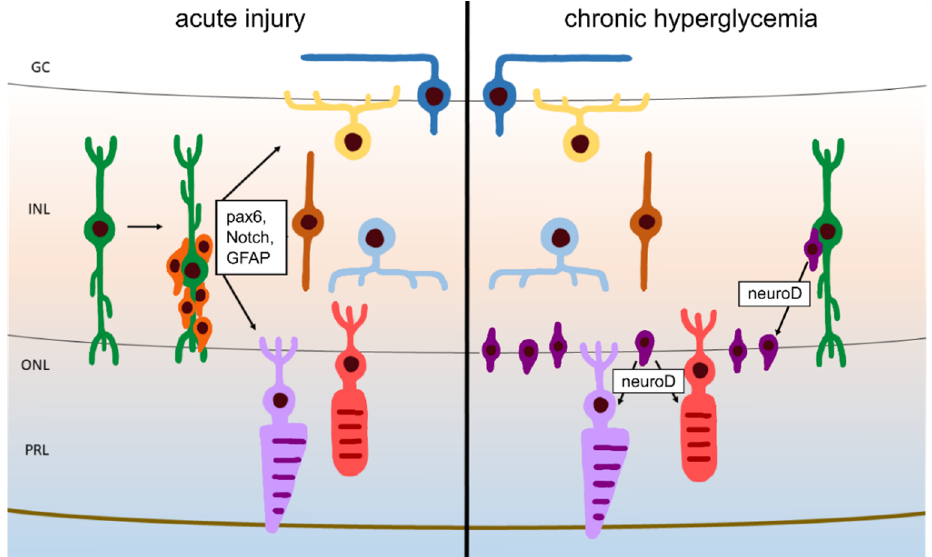
Figure 9. Our proposed model of regeneration during chronic hyperglycemia versus regeneration upon acute injury. Following acute injury, activated Müller glia divide to produce multipotent progenitors that can give rise to all neuronal cell types. Under conditions of chronic hyperglycemia, lost photoreceptors are replenished through neurod -expressing progenitors that likely arise in the INL. Unlike the classically described “rod progenitors”, these proliferative progenitors give rise to both rods and cones.